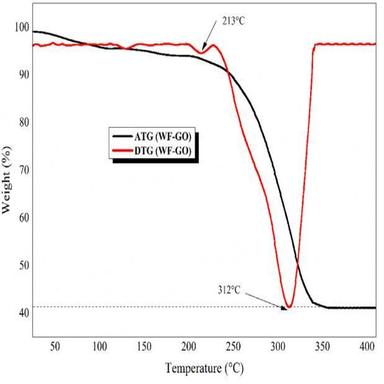
TGA and DTG curves of the (WF/GO) hybrid.